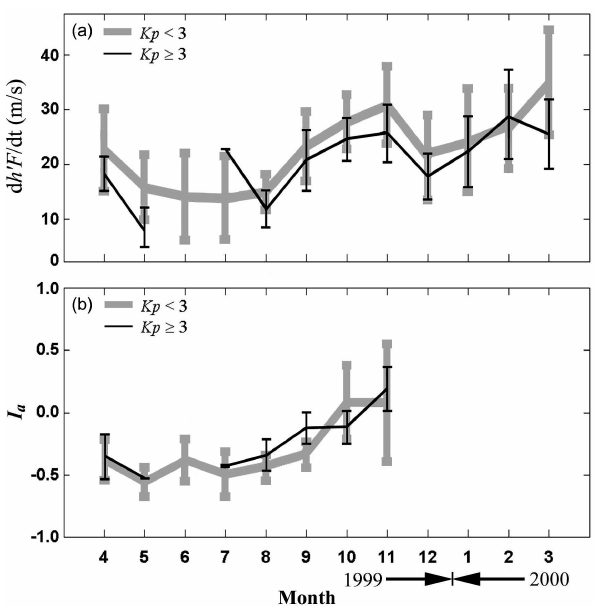
Fig. 8. Seasonal variations of the monthly mean values of d h 0 F/dt (a) and I a (b) between April 1999 and March 2000. The black thin and gray bold lines represent the mean values under the disturbed ( K p ≥ 3) and quiet ( K p < 3) conditions, respectively. The error bars are the associated standard